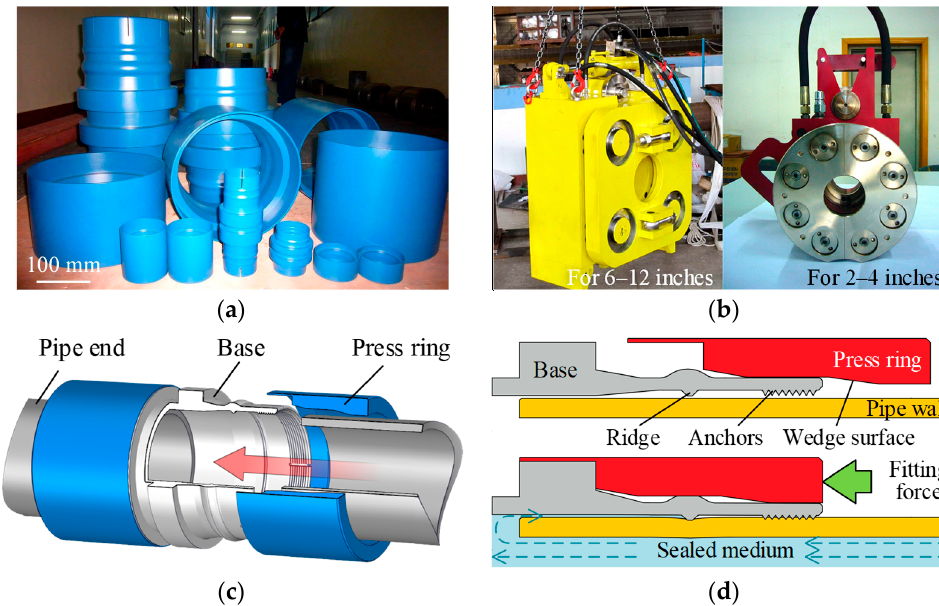
Figure 1. ( a ) Compression connector parts; ( b ) fitting tools; ( c ) connector assembly; ( d ) fitting pro ‐ cess.